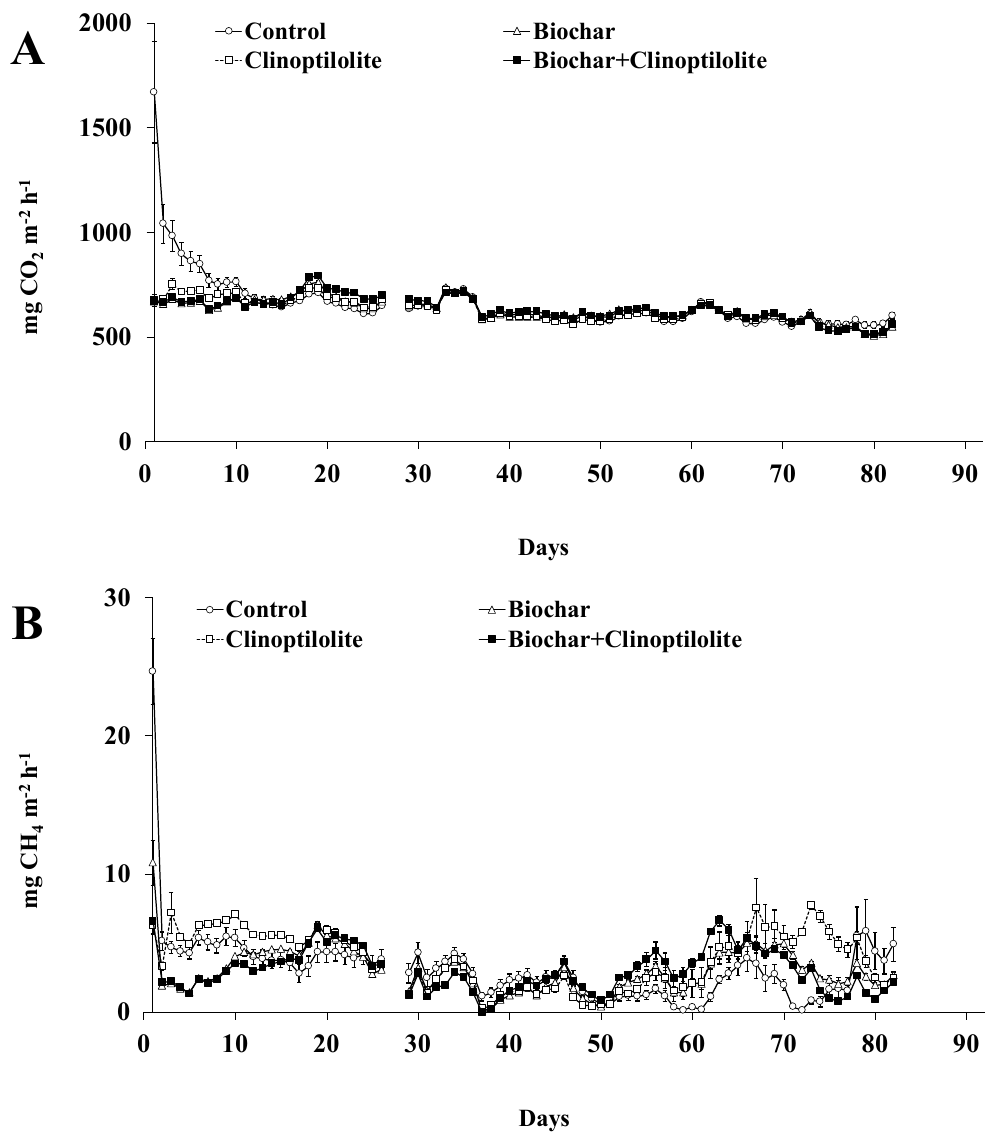
Figure 3. Carbon dioxide ( A ) and methane ( B ) fluxes from each treatment. Vertical bars represent the standard error of the mean ( n = 3).